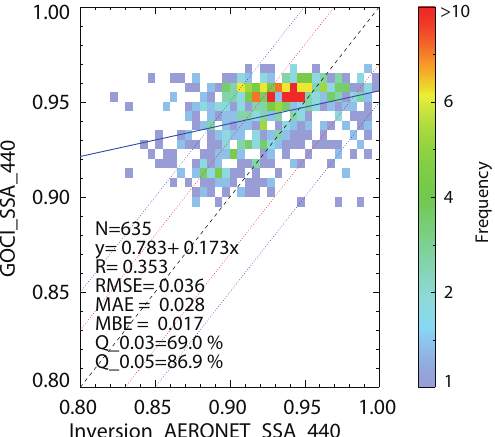
Figure 12. Comparison of SSA between inversion AERONET and GOCI. Colored pixels represent a bin size of 0.005. Dashed and solid lines denote the same as Fig. 9. Red and blue dotted lines denote the ± 0.03 and ± 0.05 ranges,